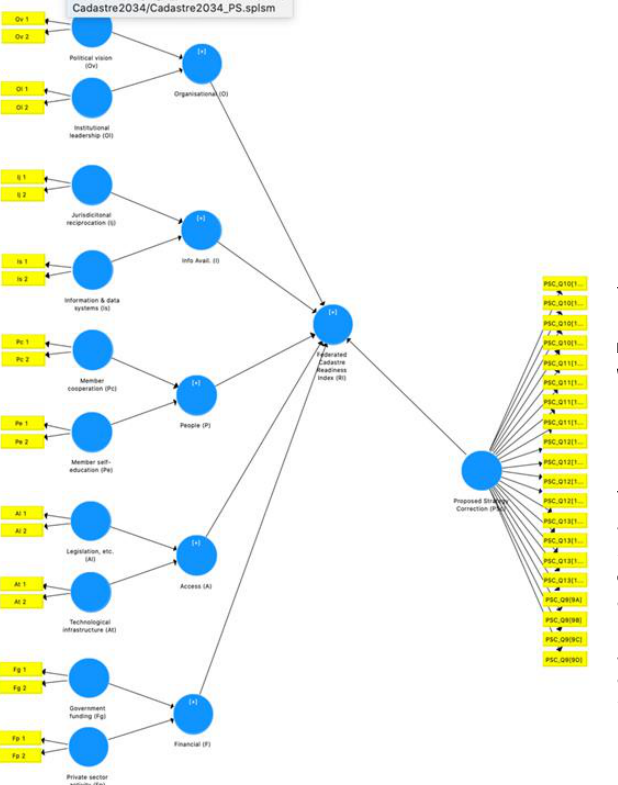
Figure 9 . SmartPLS – proposed strategy correction resulting at 0.987 R